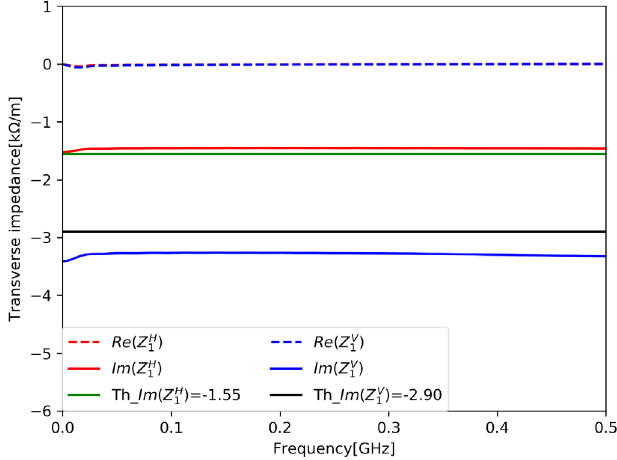
FIG. 3. Real and imaginary part of transverse broadband impedance for the ceramic rings. Re ð Z H 1 Þ and Im ð Z H 1 Þ are the real and imaginary part of horizontal broadband impedance, Re ð Z V 1 Þ and Im ð Z V 1 Þ are the real and imaginary part of vertical broadband impedance, Th Im ð Z H 1 Þ and Th Im ð Z V 1 Þ are the theoretical value of the imaginary part of horizontal and vertical broadband impedance.